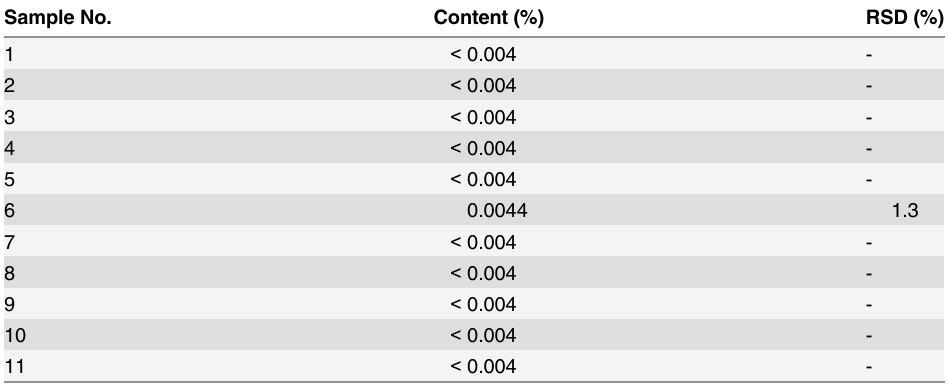
Table 2. The L, D-APM and/or D, L-APM contents of commercially available L, L-APM samples. Sample No. Content (%) RSD (%) 1 < 0.004 - 2 < 0.004 - 3 < 0.004 - 4 < 0.004 - 5 < 0.004 - 6 0.0044 1.3 < 0.004 - 8 < 0.004 - 9 < 0.004 - 10 < 0.004 - 11 < 0.004 - The L, D-APM and/or D, L-APM of sample No.6 is the mean of three independent